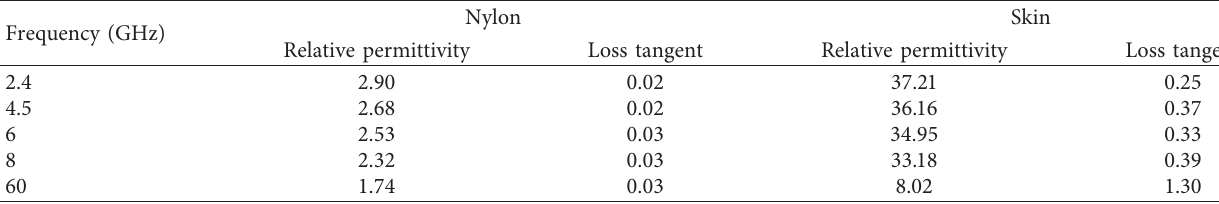
Table 3: Material electrical parameters.